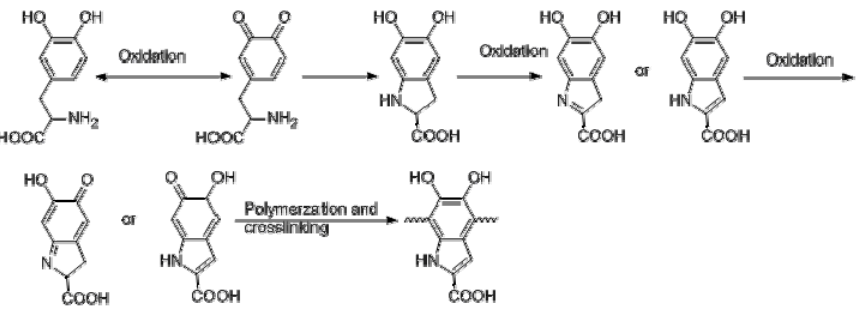
Scheme 2. Possible polymerization mechanism of L -DOPA.